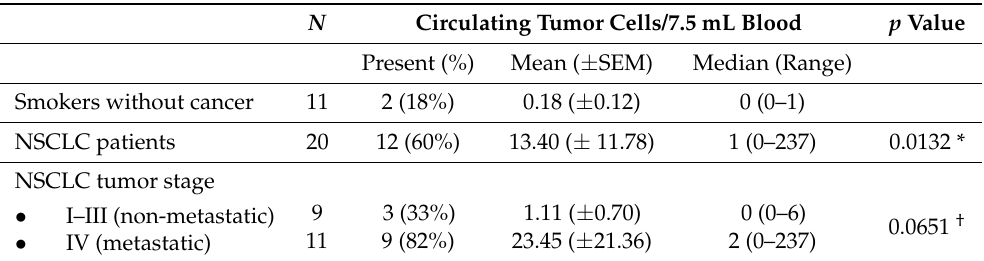
Figure 1. Four-channel fluorescent images of circulating tumor cells (CTCs) detected in NSCLC pa- tients’ blood (7.5 mL). CTCs from two different NSCLC patients are shown, identified as cytokeratin (CK)/EpCAM+ and CD45- cells with DAPI+ nuclei. (Magnification ×10). Table 2. CTC enumeration in control high-risk subjects without cancer and NSCLC patients. N Circulating Tumor Cells/7.5 mL Blood p Value N Present (%) Mean ( ± SEM) Median (Range)